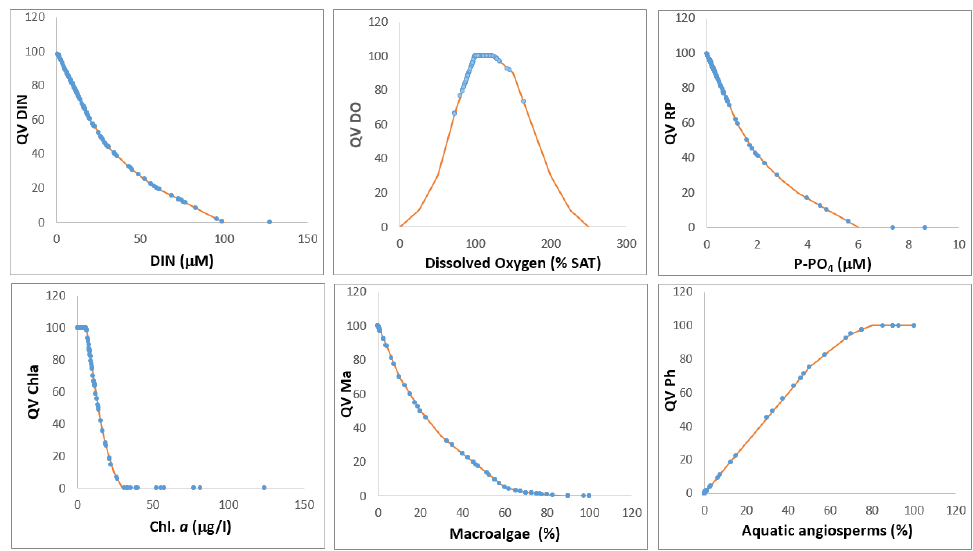
Figure 3. Phase 2. Distribution of collected data (blue dots) over the quality values curves (orange lines) set for the assessment of the metrics composing the TWQI index.